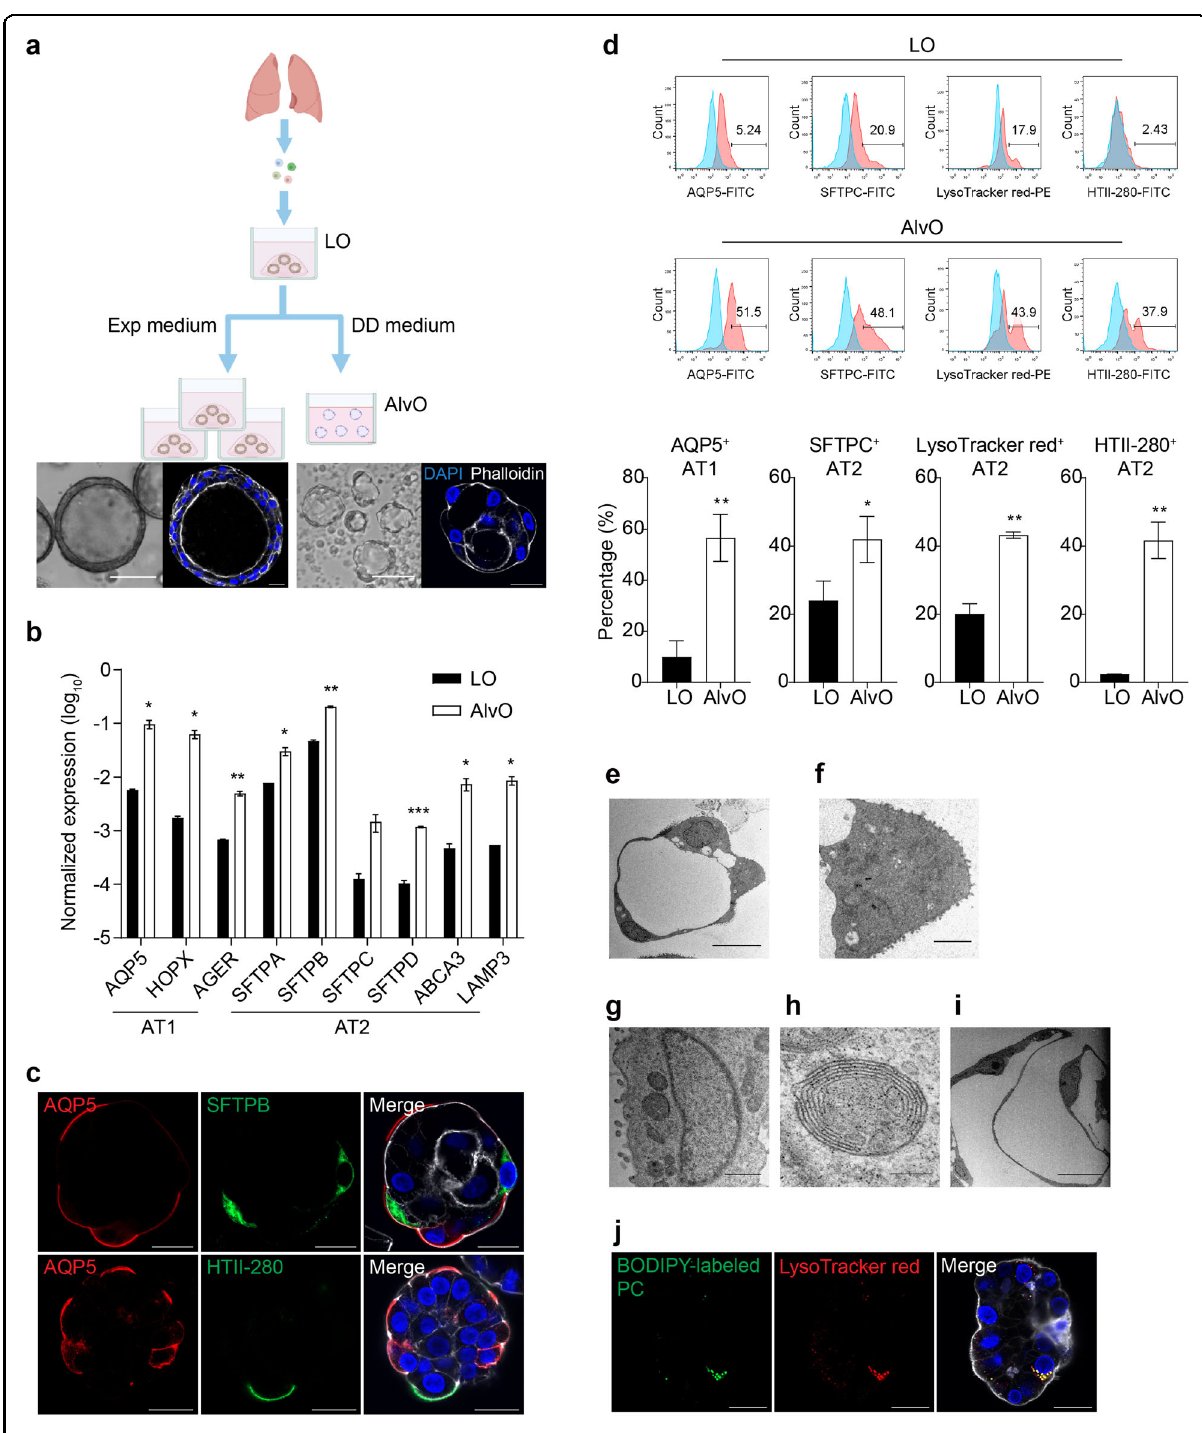
Fig. 1 (See legend on next